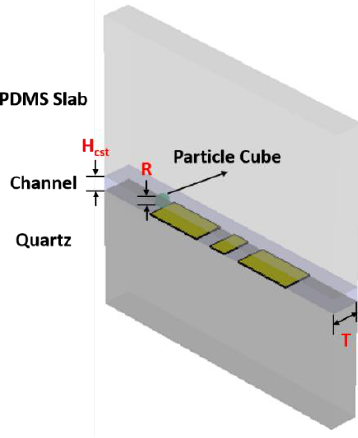
Figure 6. The CST simulation model of the sensing CPW structure (Au) on quartz substrate with microfluidic channel (DI water) on top and covered with PDMS slab. The cubic particle (polystyrene) with a side length R of 3 µ m is placed at a different position relative to the sensing CPW, with its center height of 2.5 µ m. The liquid channel H cst is 5 µ m here in the model and the length T is 10 µ m.